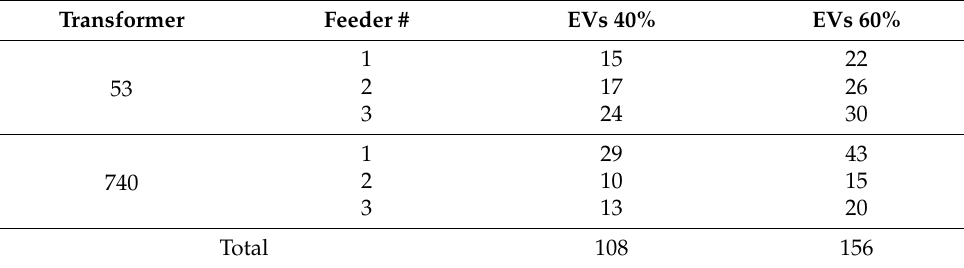
Table 4. Number of EVs per feeder for 40% and 60% EVC penetration levels.